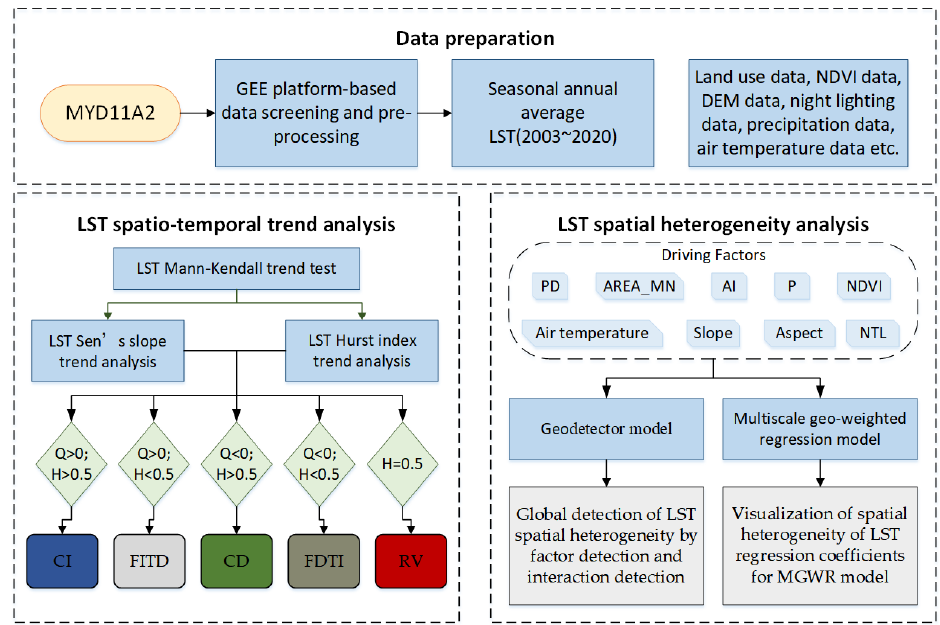
Figure 2. Research framework.